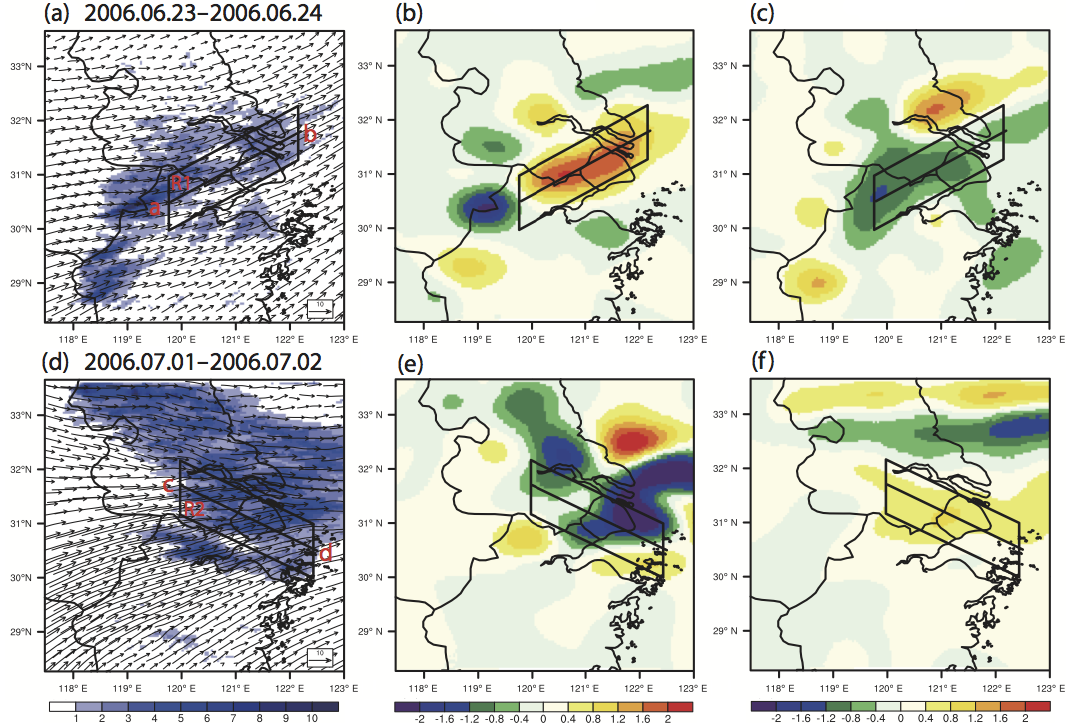
Figure 12. Rain rate (units: mmh − 1 ) superimposed with wind vectors at 850hPa for case A from 08:00 on 23 June 2006 to 08:00 24 June 2006 (LST): (a) simulated in the LU06E06 simulation; (b) differences between LU06E70 and LU70E70; (c) differences between LU70E06 and LU70E70. Panels (d–f) are the same as (a–c) but for case B from 08:00 on 1 July 2006 to 08:00 on 2 July 2006 (LST). The boxes R1 in (a) and R2 in (d) outline the three regions over which further analysis are conducted. Lines across the center of each box mark the cross sections to be